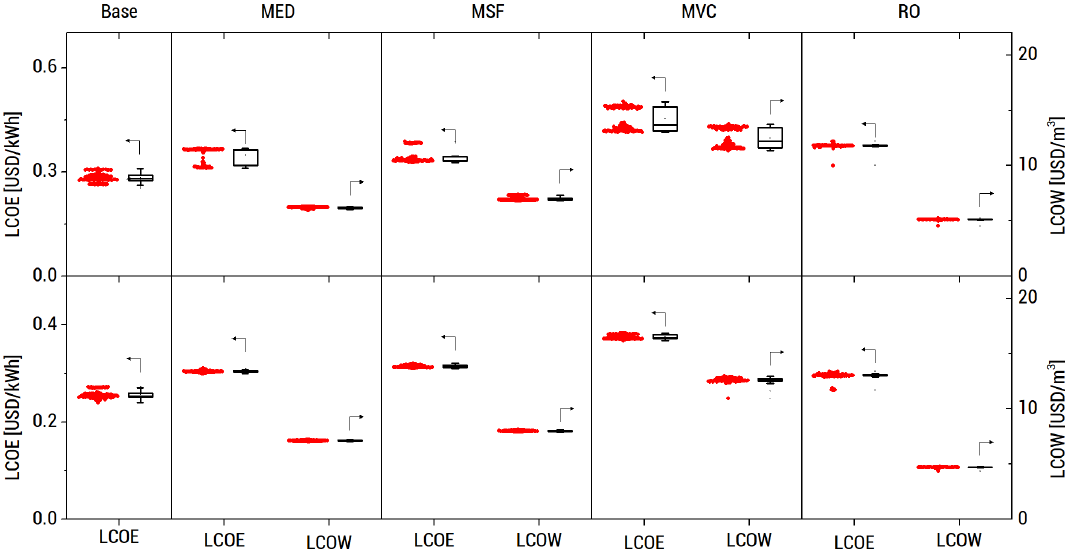
Figure 10. Distribution of optimum LCOE ( left axis) and levelized cost of water (LCOW) ( right axis) on Camasusu Island ( top ) and Lubang Island ( bottom ). The metrics of the MED and MVC systems in Camasusu exhibit a bimodal distribution.